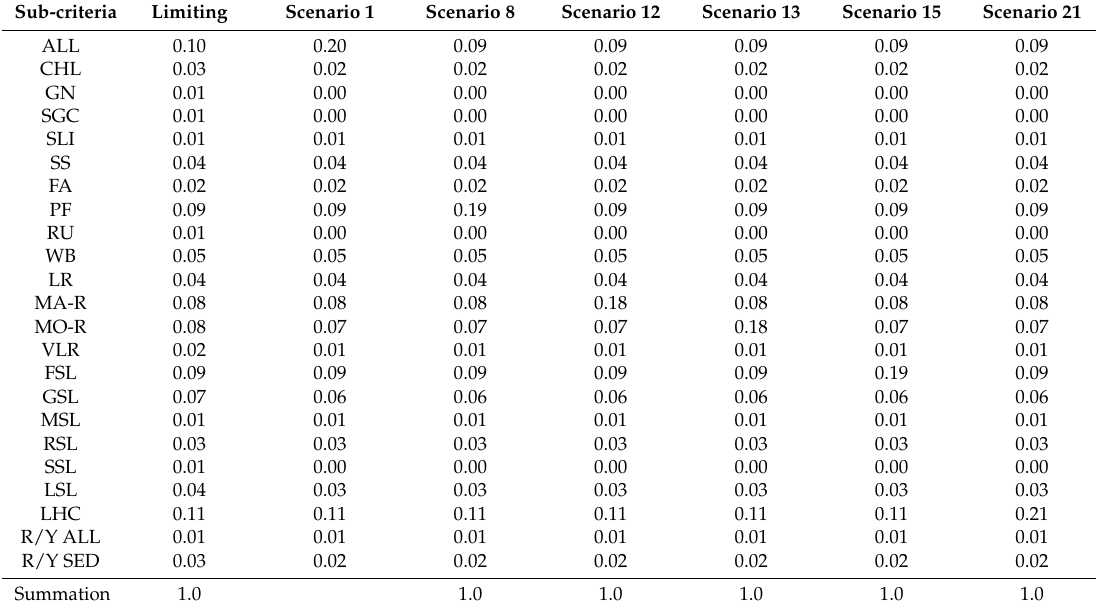
Table 6. Sensitivity